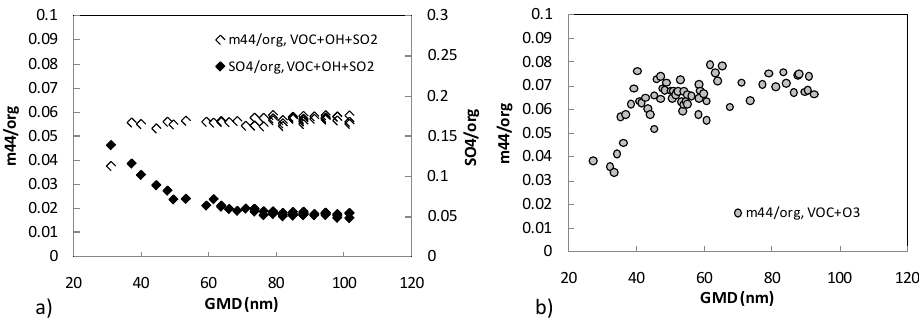
Fig. 4. m 44/total organics ratio of particles derived from (a) OH initiated oxidation of the pine emitted VOCs, in the presence of SO 2 , and (b) ozonolysis of the pine-emitted Figure 4.